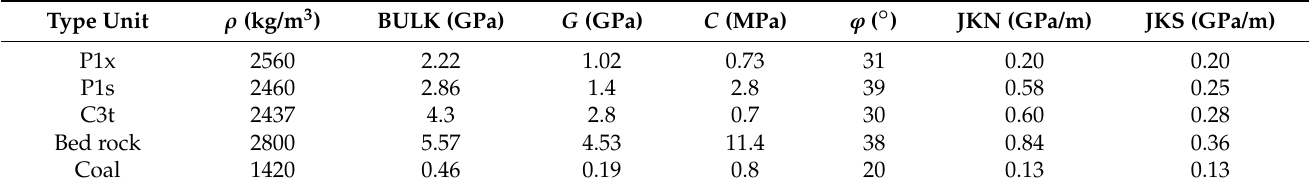
Table 3. The physical and mechanical parameters and the parameters of the joint [47].